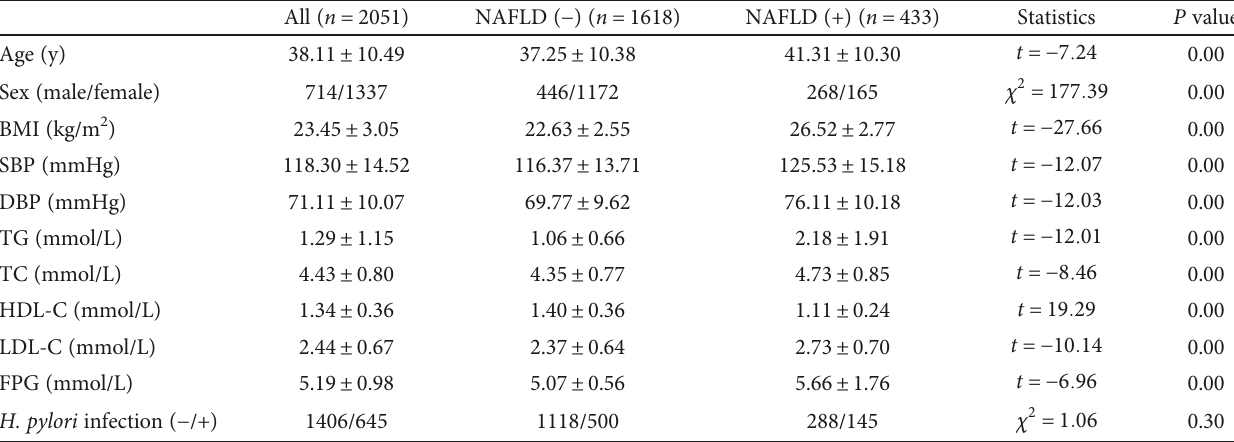
Table 2: Baseline characteristics of study